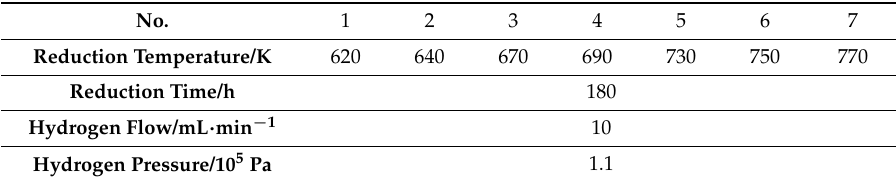
Table 2. The hydrogen reduction parameters of the MCP multipliers.